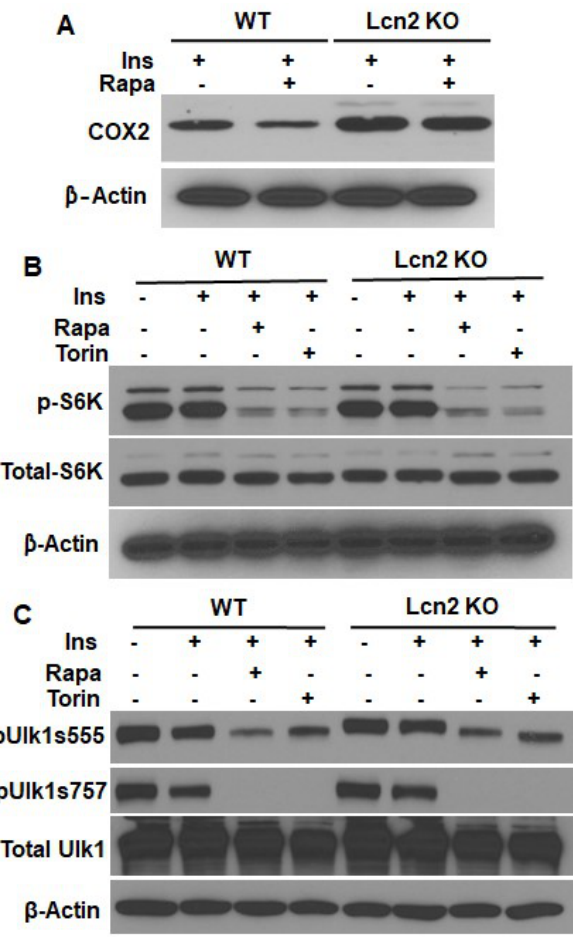
Figure 4. Effect of mTORC1 inhibition by rapamycin on COX2, p70 S6Kinase, and ULK1 activation in inguinal adipocytes. ( A ) COX2 protein levels by rapamycin in WT and Lcn2 KO adipocytes. Phosphorylation of p70 S6Kinase ( B ) and ULK1 ( C ) by rapamycin and Torin in the presence of insulin (Ins) in WT and Lcn2 KO adipocytes. Blots represent the results from one of 2–3 experiments.